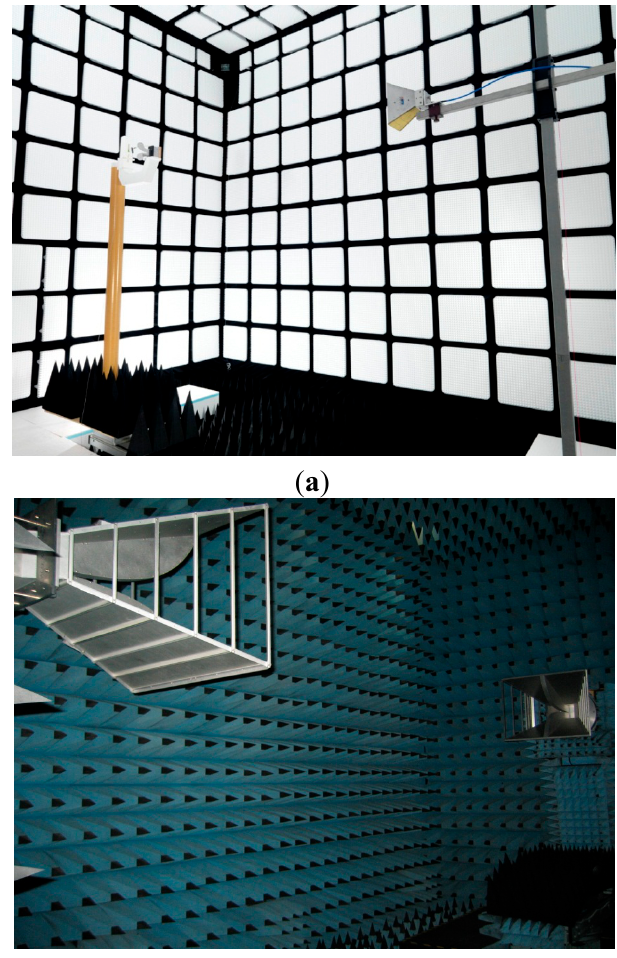
Figure 1. ( a ) The National Physical Laboratory (NPL) Small-Antenna Radiated